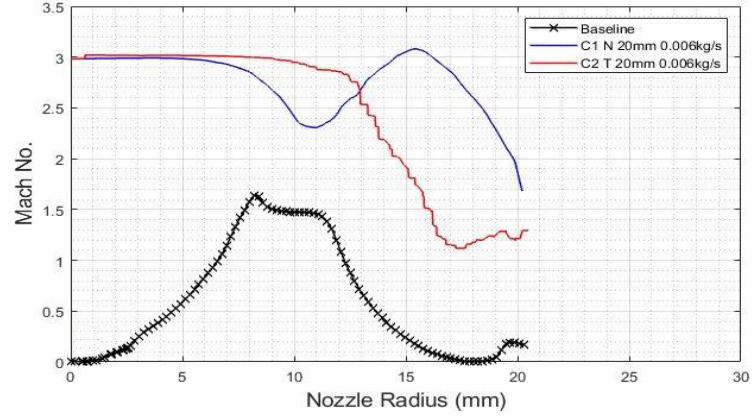
Figure 9. Mach no. vs. nozzle radius of C1 and C2.